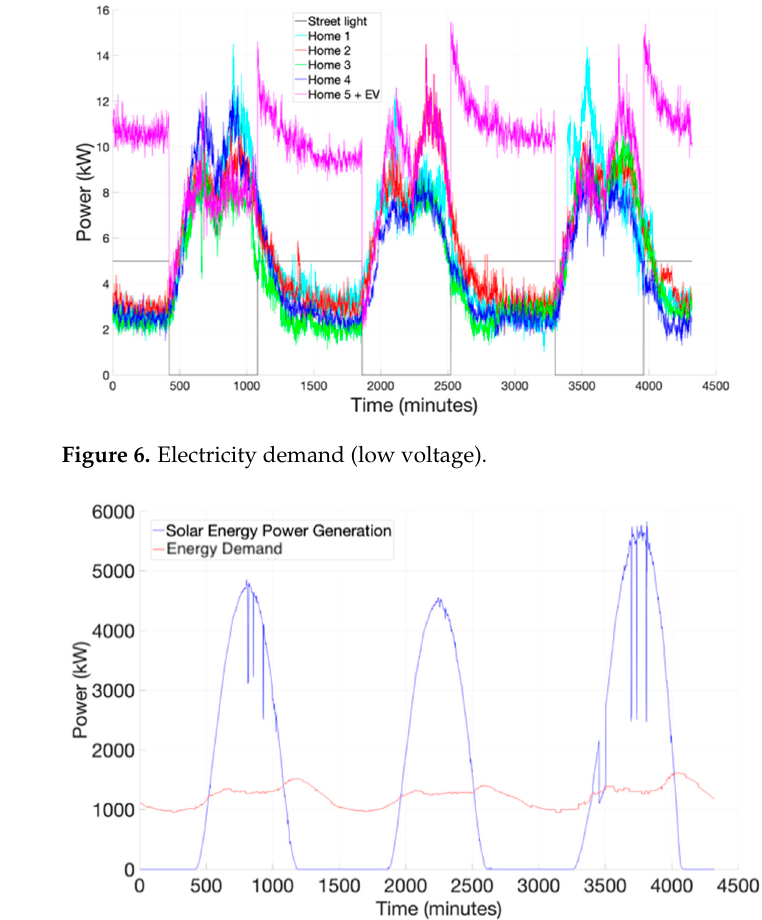
Figure 7. Total Generation and Total Electricity Demand.